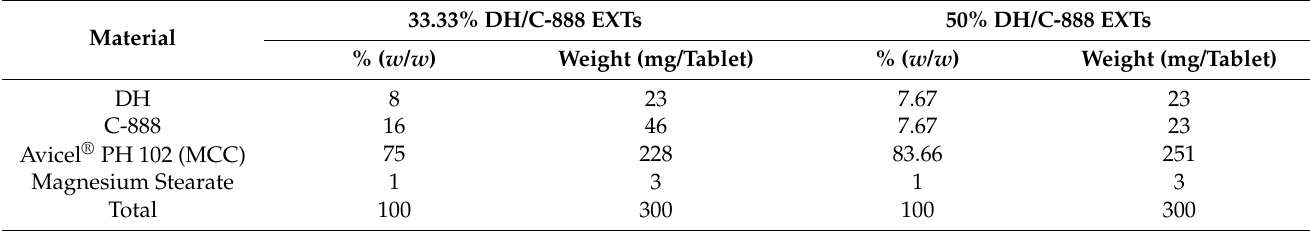
Table 5. Tablet compositions for conventionally processed, 300 mg tablets. MCC: microcrystalline cellulose; EXT: extrudate. Material